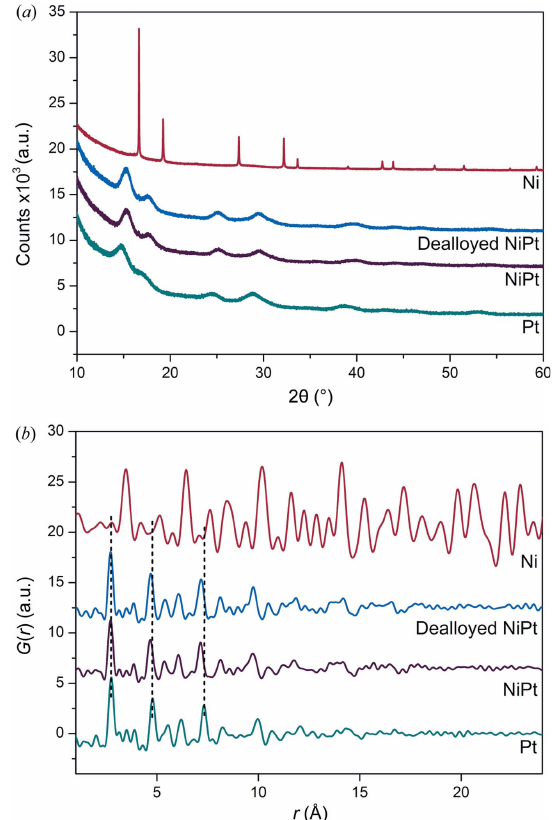
Figure 8 ( a ) Diffraction patterns and ( b ) PDFs of the Ni, NiPt, dealloyed NiPt and Pt